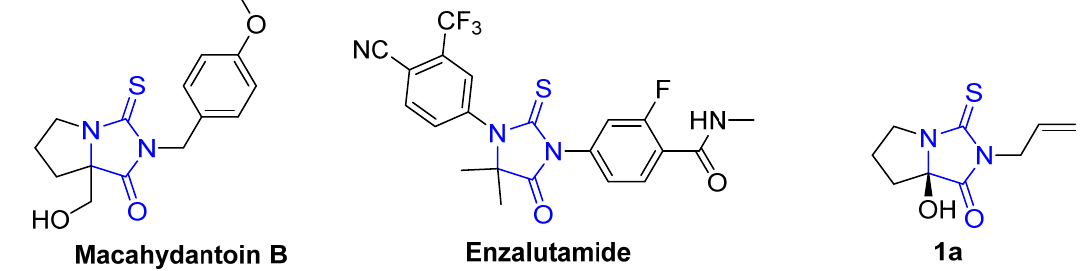
Figure 1. Selected natural and FDA-approved 2-thioxoimidazolidin-4-one analogues.